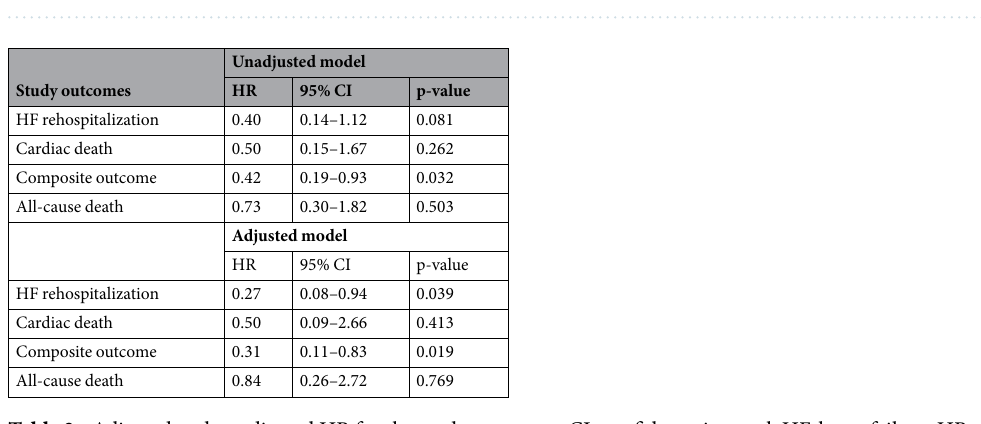
Figure 2. Cumulative incidence of rehospitalization for worsening HF (panel A), composite outcome (panel B), cardiac death (panel C) and all-cause death (panel D) in Sacubitril/Valsartan and standard therapy groups HF, heart failure.